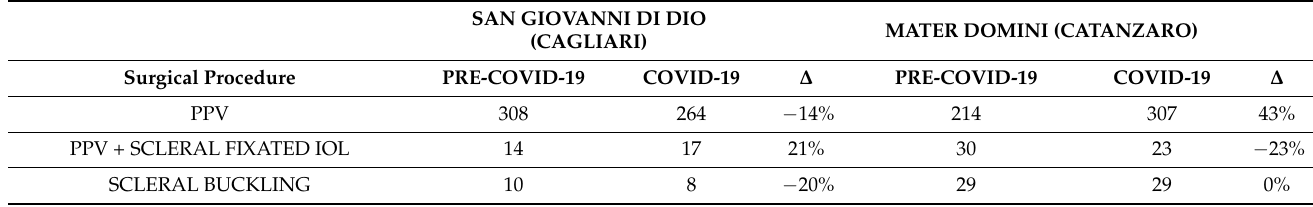
Table 6. Comparison of different types of vitreoretinal surgical procedures at San Giovanni di Dio (SGD), University of Cagliari, and Mater Domini, University Magna Græcia of Catanzaro (UMG).